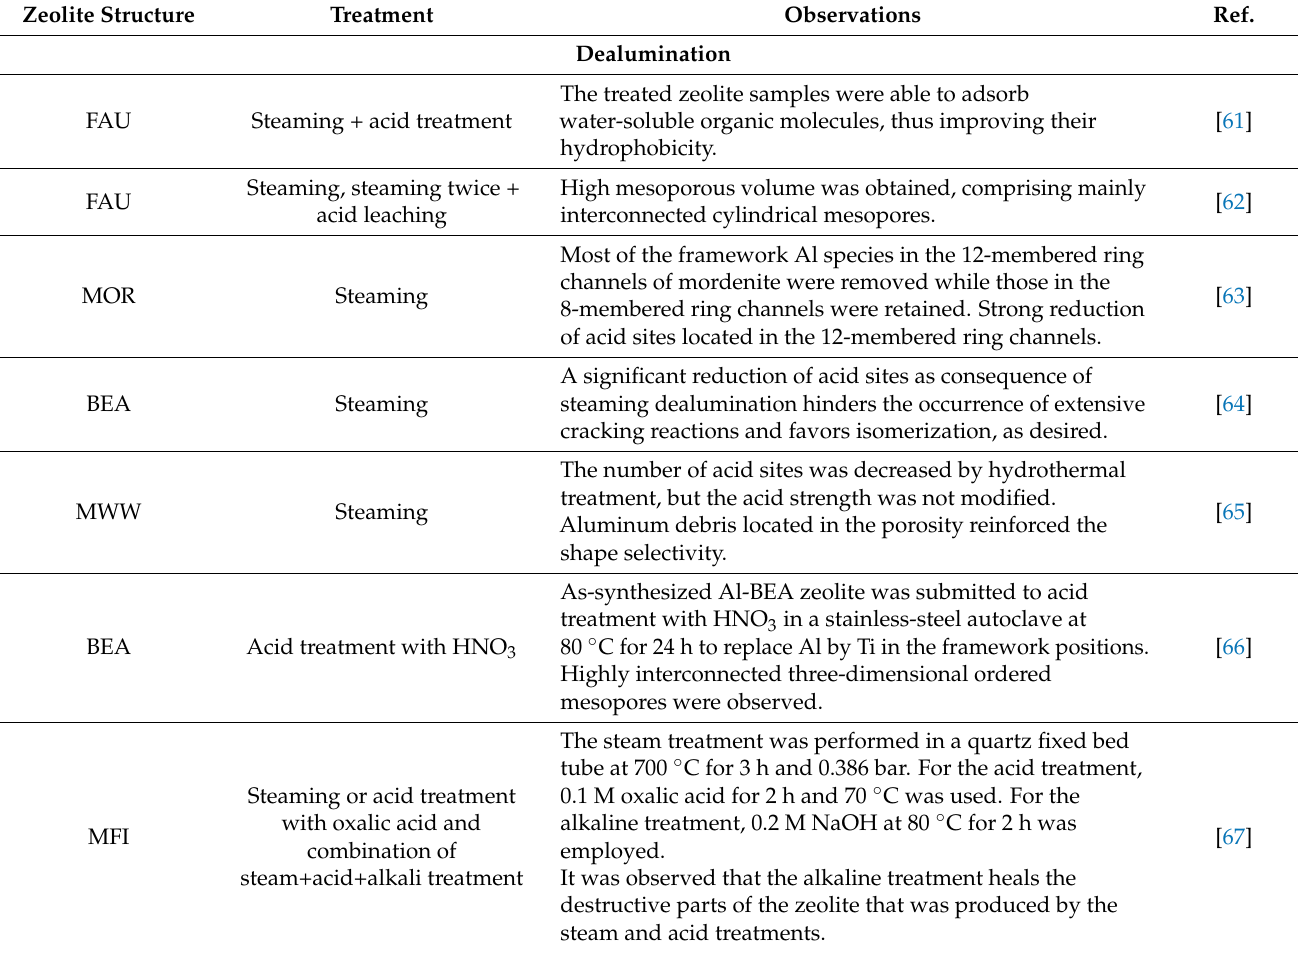
Table 2. Examples of recent studies on dealumination and desilication processes used to prepare hierarchical zeolite